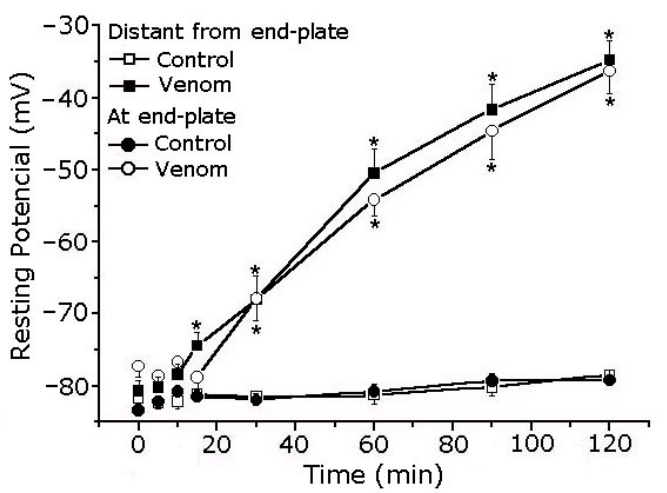
Figure 4. Resting potential (RP) of mouse diaphragm preparations obtained at or distant from the end-plate regions. There was no significant difference in effects between these two regions. Preparations incubated with Tyrode solution showed no change in RP. The depolarizing effect of B. n. pauloensis venom (20 µ g/ml) was gradual. The points are mean ± S.E.M. of four experiments. All points indicated by an asterisk differed significantly from the control preparations ( p < 0.05).